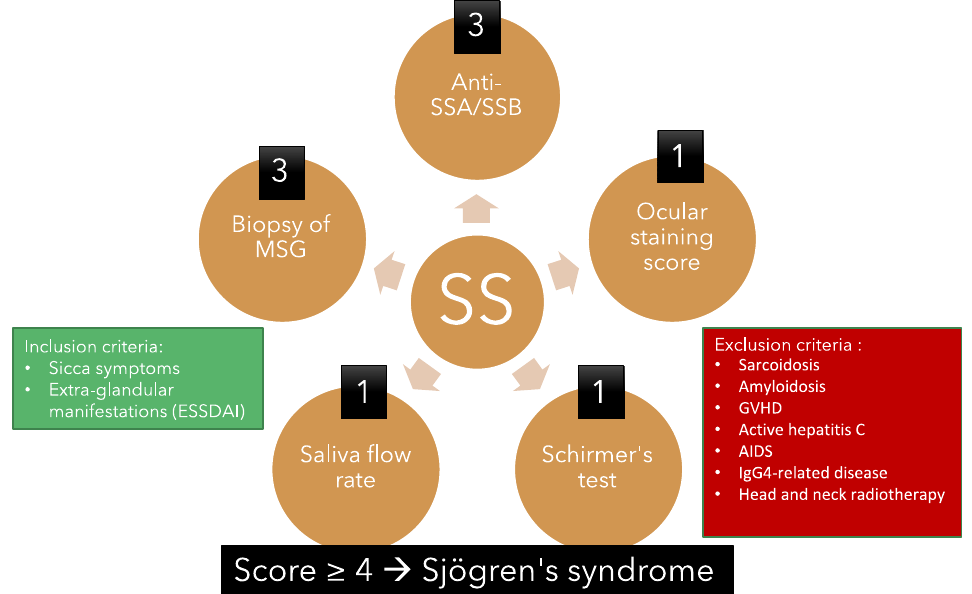
Figure 3. Overview of the American College of Rheumatology/European League Against Rheuma- tism criteria for primary Sjögren’s syndrome 2016. This classification criteria applies to an individual who meets one of the inclusion criteria and does not have any of the exclusion criteria. A score of 4 or above confirms the diagnosis of pSS.